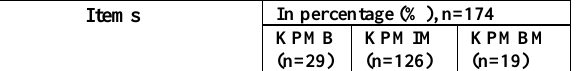
Table 1. Internet usage duration, frequency, and Internet skills